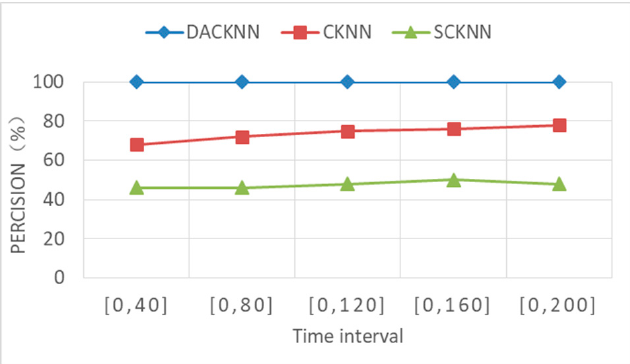
Figure 18. Accuracy of algorithms under different time intervals.